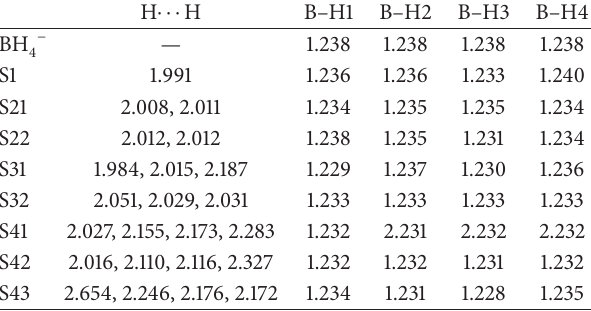
Table 3: Bond lengths (˚A) of hydrogen bonded clusters at